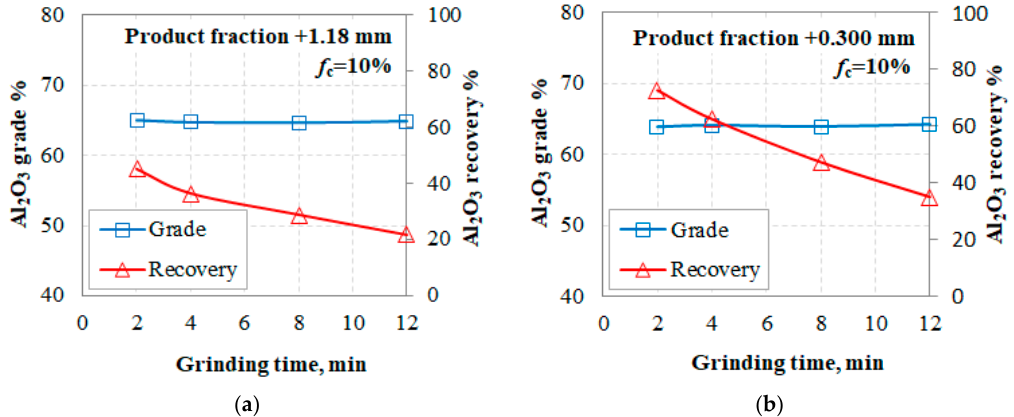
Figure 7. Effect of grinding time on Al 2 O 3 grade and recovery for the product fraction coarser than ( a ) 1.18 mm and ( b ) 0.300 mm, when f c = 10%.